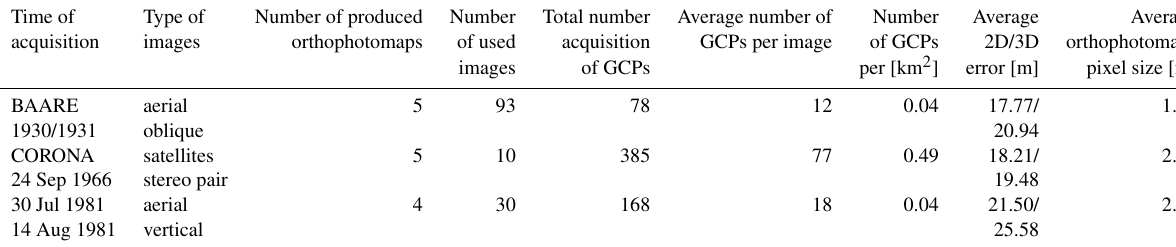
Table 1. Archival orthophotomaps: input data, quality, and accuracy overview.